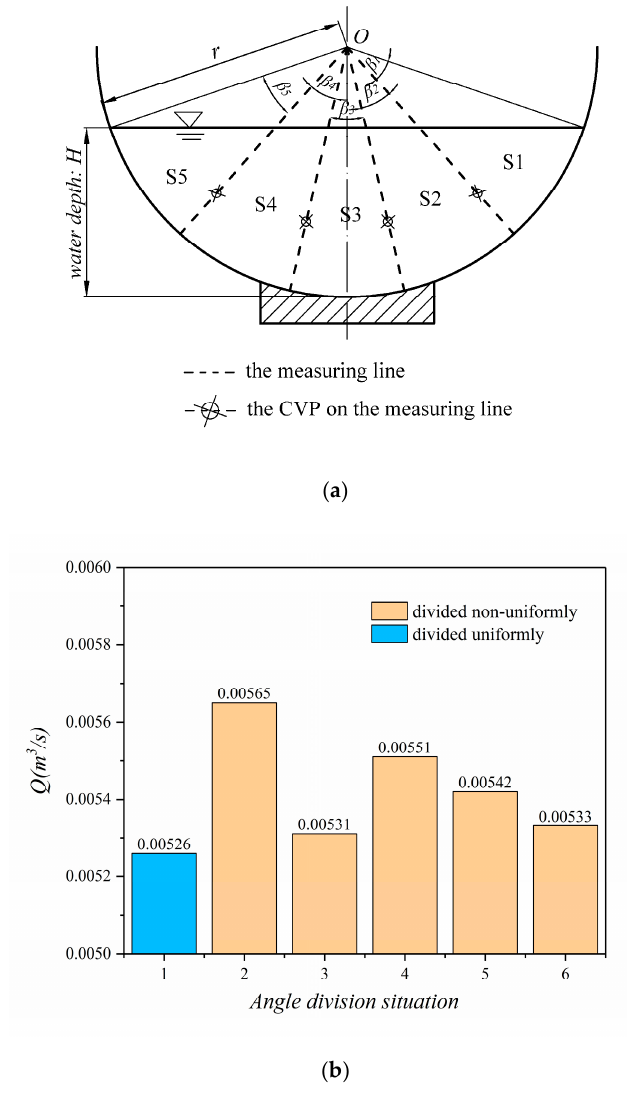
Figure 8. Estimating discharge of different angle combinations of four measuring lines (C1): ( a ) The angle Ω is divided to different sub-angles with four measuring lines. ( b ) The relationship between angle division situation and calculated discharge.